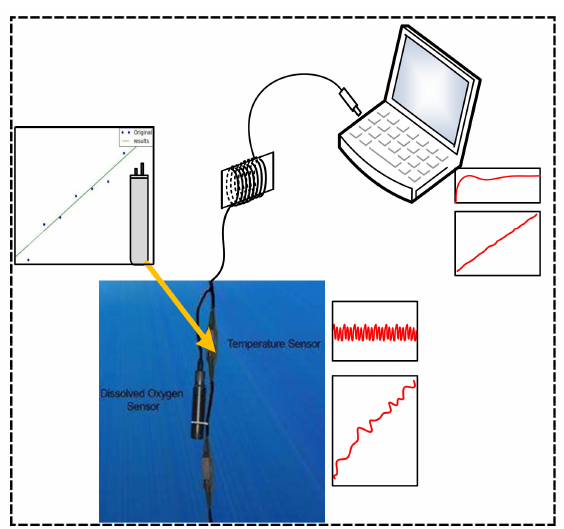
Figure 1. The algorithm application diagram, the upper left picture is the temperature sensor data fit, and the red waveform is a schematic diagram of the collected temperature